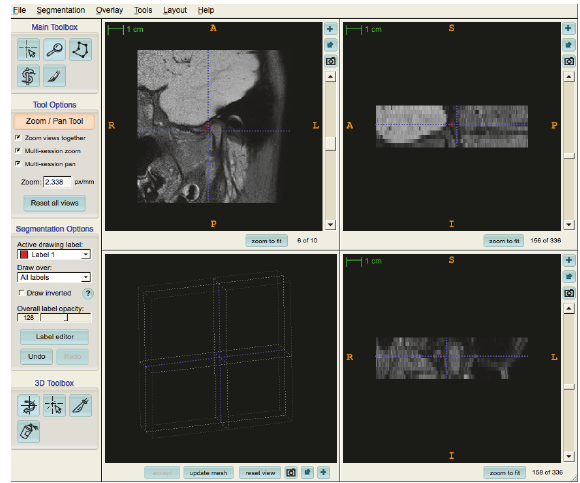
Figure 1: Software interface showing delimitation of the articular eminence in the sagittal plane on